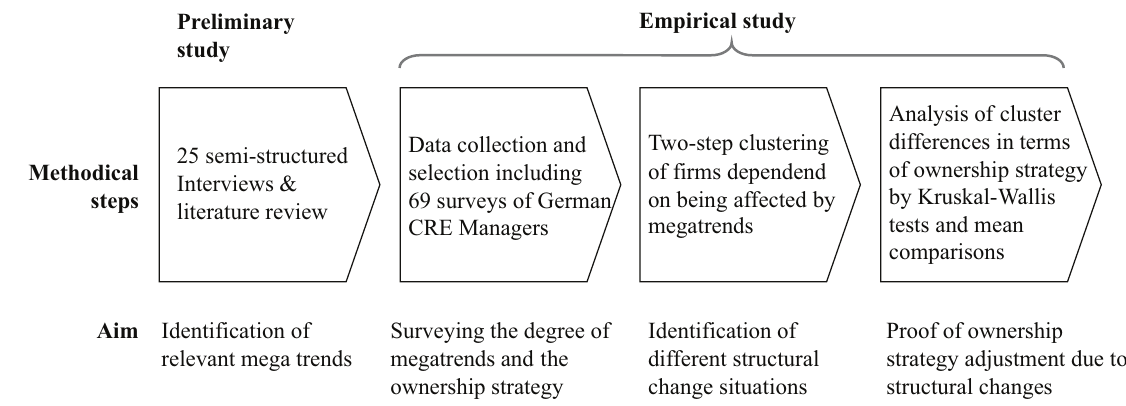
Figure 2. Visualisation of research design and methodology